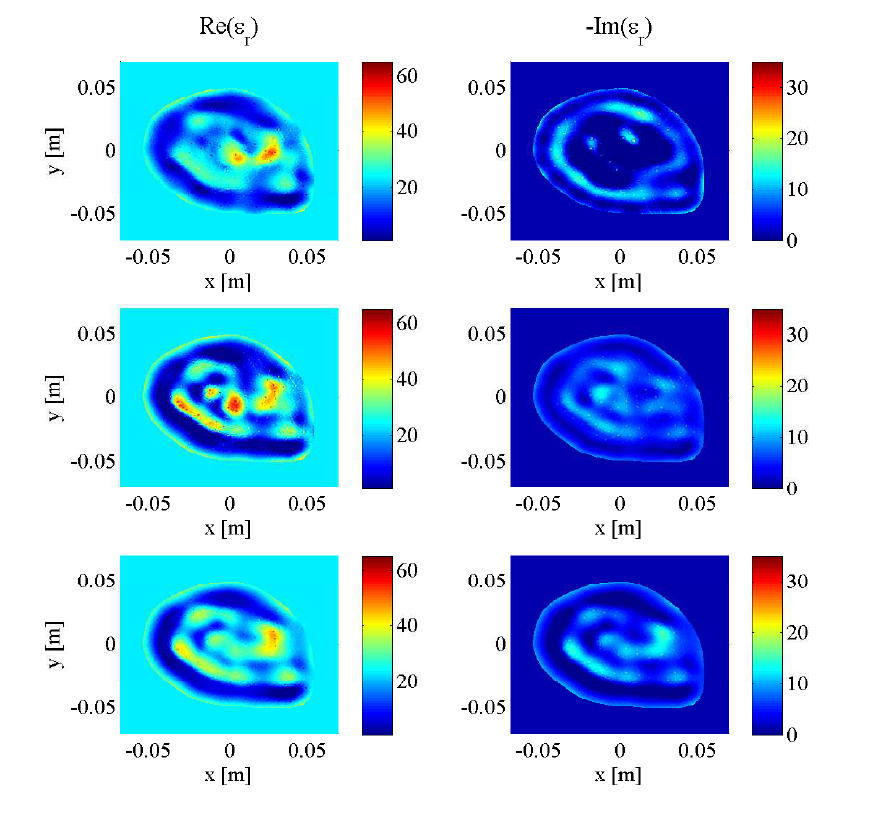
Figure 9. Final results of DGM-CSI frequency-hopping and frequency-cycled complex dielectric property reconstruction of PEC-bounded synthetic breast model using 1.0–1.5 GHz data, without modification of intermediate initial guesses (Scenario D— top ), using tissue-dependent mapping at fixed 200 iterations per frequency (Scenario E— middle ), and employing stopping criteria and tissue-dependent mapping (Scenario F— bottom